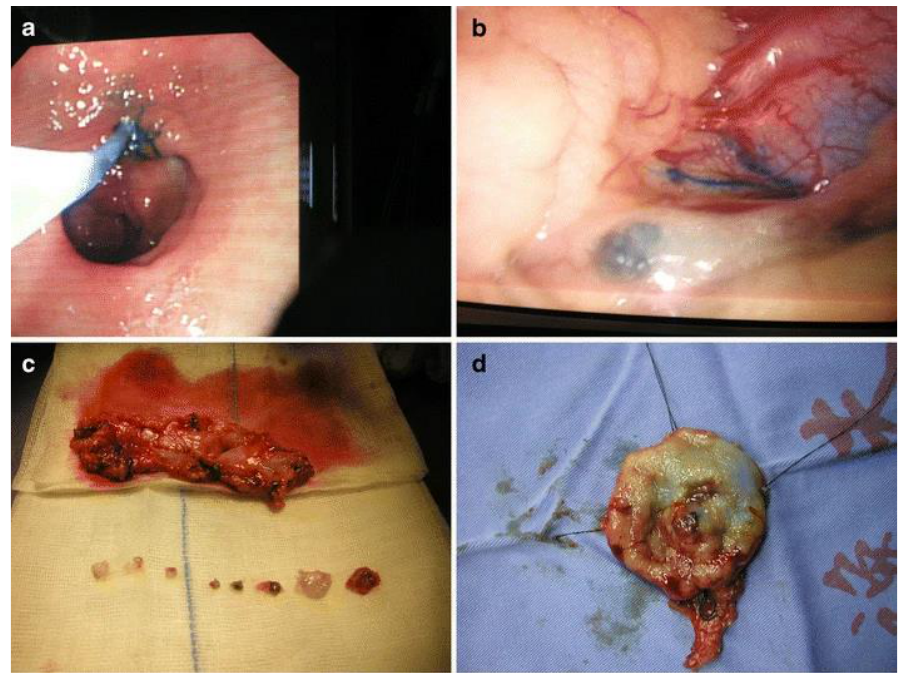
Figure 1. Procedure for laparoscopic local resection with sentinel node biopsy. ( a ) Isosulfan blue was injected into the peritumoral submucosal layer after the lesion was localized through an intraoperative endoscopy. ( b ) Within 5 min of dye injection, lymphatic flow from the lesion was visible. ( c ) Sentinel nodes were isolated, while perigastric tissue was extracted. ( d ) Local resection lines were marked at the four edges of the resection margin. Reproduced with permission [33]. Copyright 2008, Springer Nature.